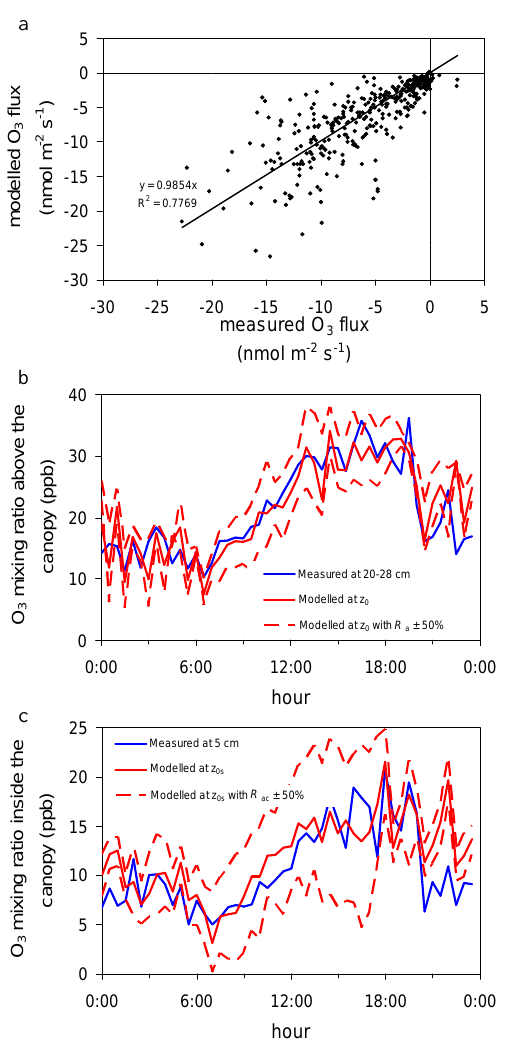
Fig. 4. Comparison between measured and modelled (a) O 3 fluxes, and O 3 mixing ratios (b) above and (c) within the canopy. Shown are median values from 29 August to 20 September 2005. Blue lines are measured mixing ratios, solid red lines are modelled mixing ratios and dotted red lines are modelled mixing ratios with an uncertainty of ± 50% for the aerodynamic resistances. For details see text.